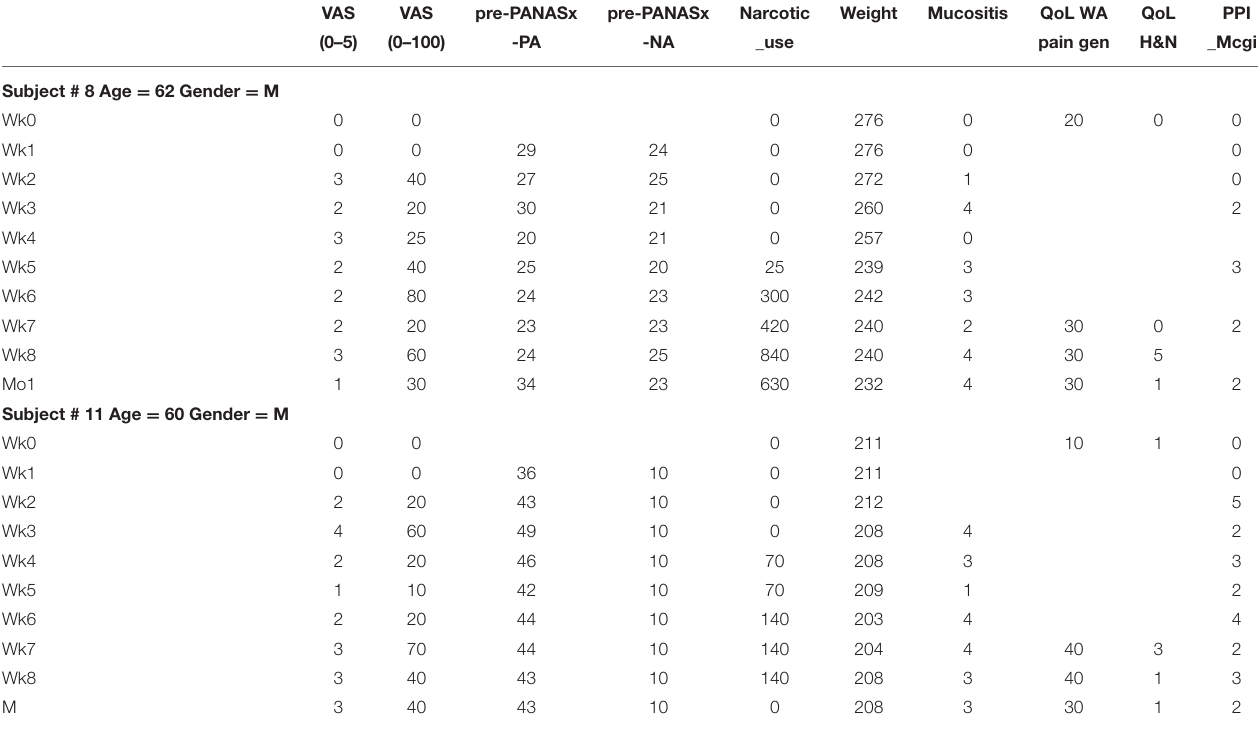
TABLE 3 | Preliminary demographic and clinical measurement data collected from two patients. VAS VAS pre-PANASx pre-PANASx Narcotic Weight Mucositis QoL WA QoL PPI (0–5) (0–100) -PA -NA _use pain gen H&N